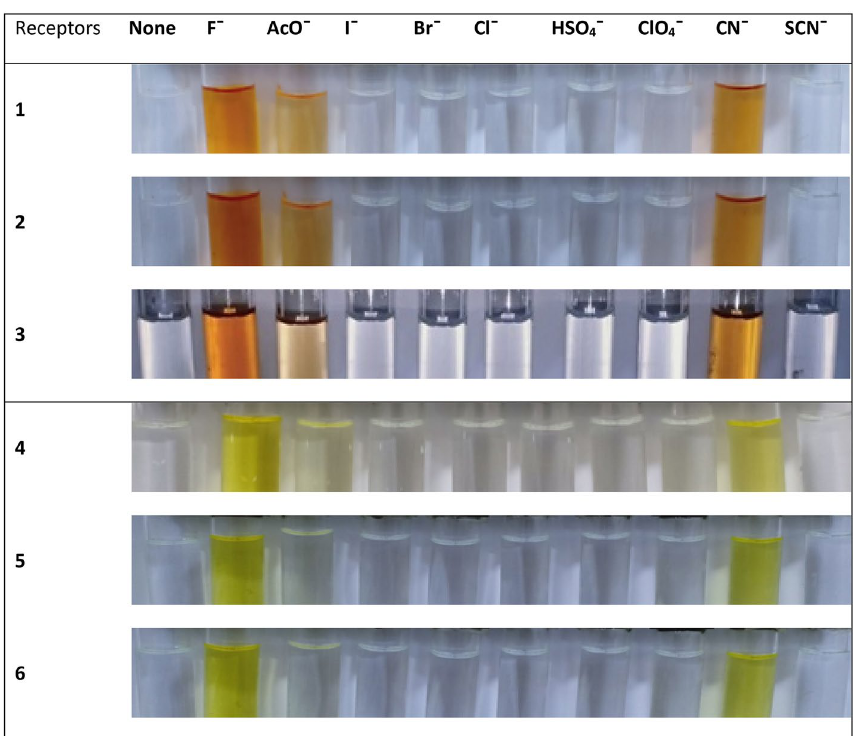
Figure 1. Visible colorimetric responses of probes 1 – 6 in CH 3 CN (5 × 10 −5 M) upon addition of 30 equiv. of various